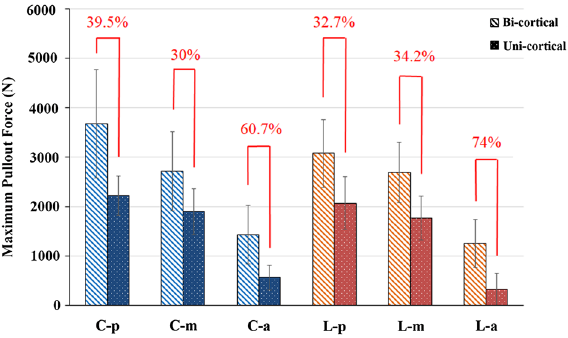
Figure 7. Comparison of maximum pullout forces between bicortical and unicortical fixation